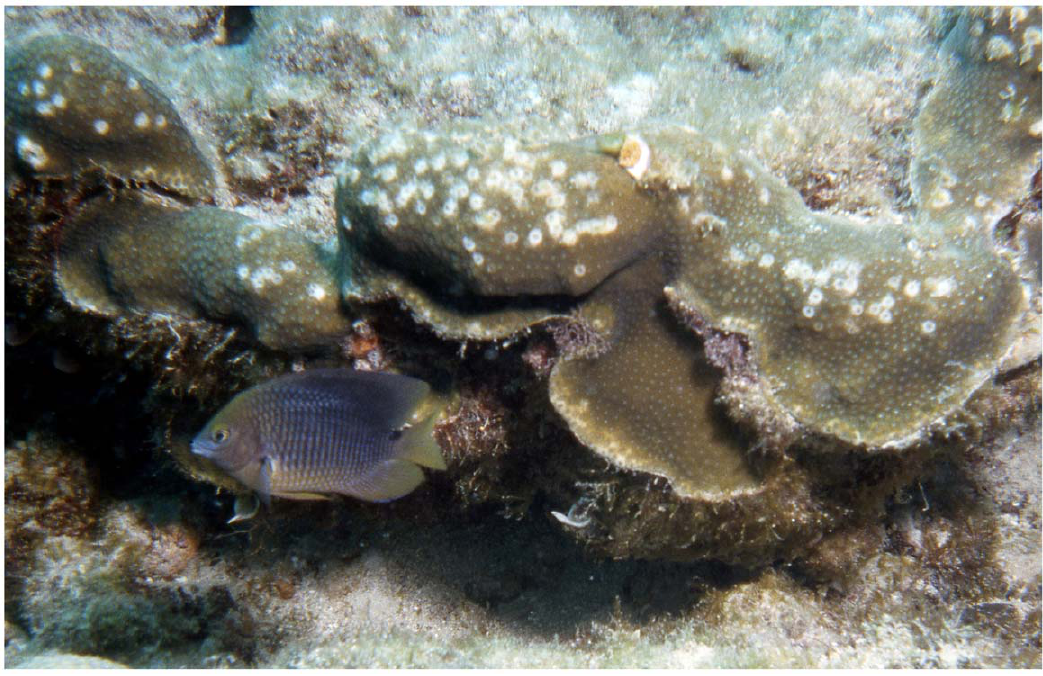
Figure 1. A threespot damselfish, Stegastesplanifrons , and its territory on a colony of Monastraeafaveolata . Note the bite-induced lesions of living coral tissue along the margin of the territory. From Carysfort Reef, Florida Keys National Marine Sanctuary; summer 2003; 10 m depth. Photo by WFP.